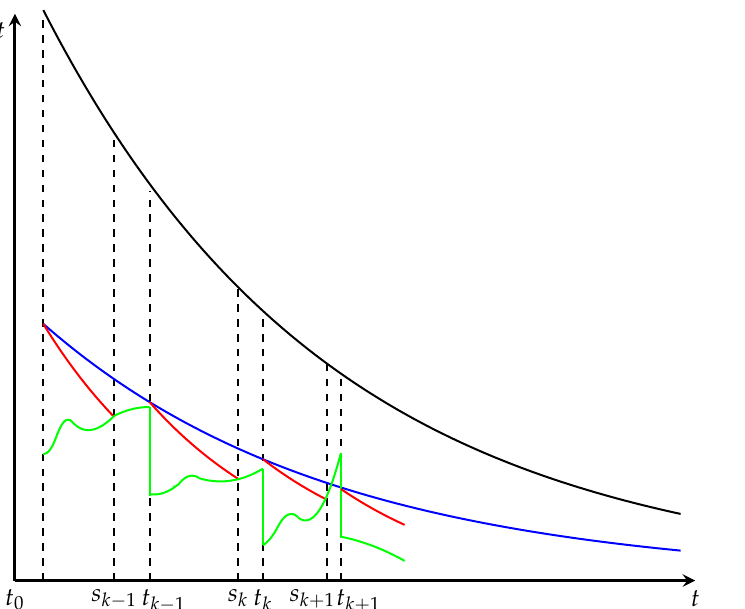
Figure 1. Black, blue, red, and green lines are described as θ h ( t ) , 1